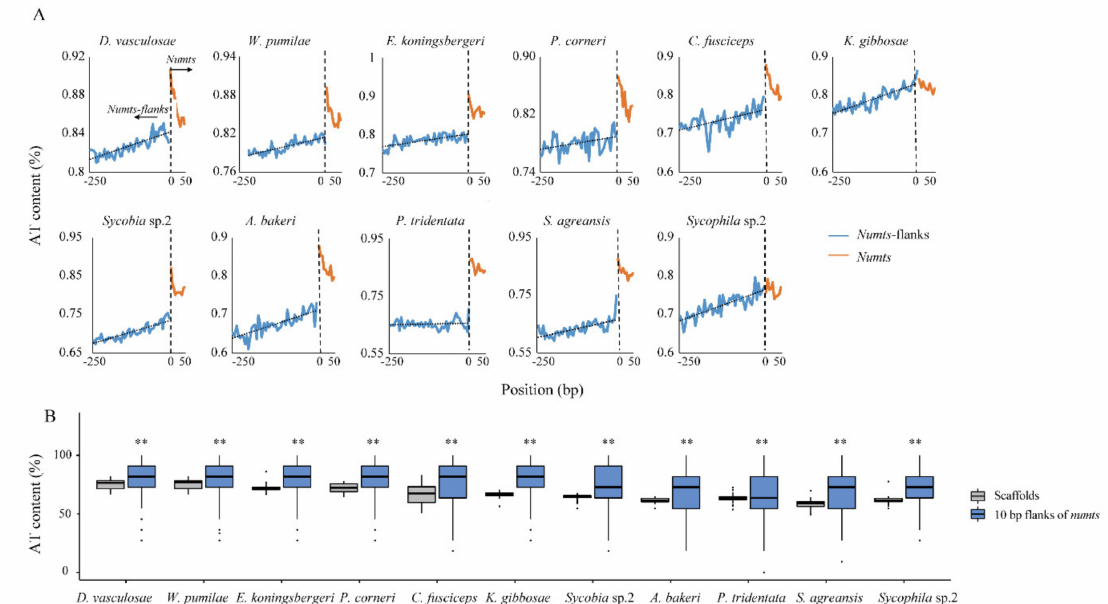
Figure 3. Mean AT content in NUMT flanking sequences. ( A ) For each species, the mean AT content (5 bp windows) of 250 bp flanks of all NUMTs (blue lines) and 50 bp at both ends of all NUMTs (orange lines) are displayed. The horizontal axis gives the positions of NUMTs and NUMT flanking regions in genome. The vertical axis gives the mean AT content at each position. ( B ) Comparison of mean AT content in the 10 bp flanking regions of all NUMTs to the mean AT content of all sca ff olds containing NUMTs in the genome. ** p < 0.01, Wilcoxon